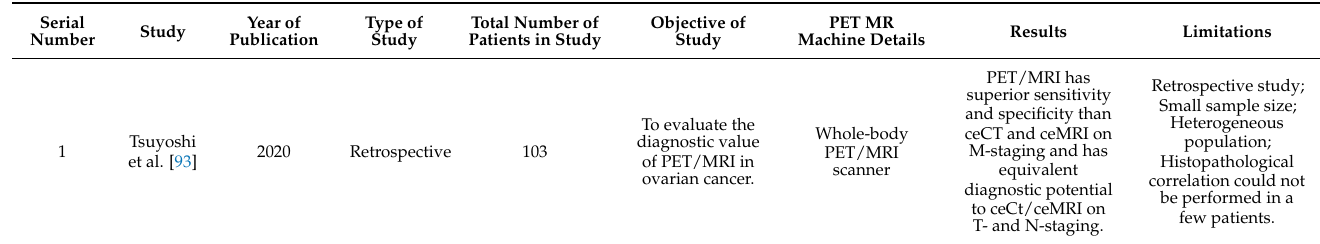
Table 7. Characteristics of PET/MRI studies in ovarian